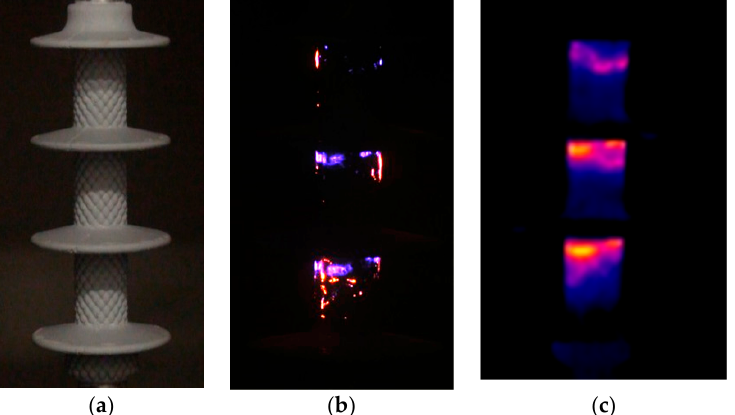
Figure 2. Visual frame before fog application ( a ), visual frame using long-exposure acquisition ( b ) and the IR frame ( c ) during the constant voltage test on sample TT4; equivalent salt deposit density (ESDD) was 0.64 mg/cm 2 with a fog spray rate of 3 L/h.